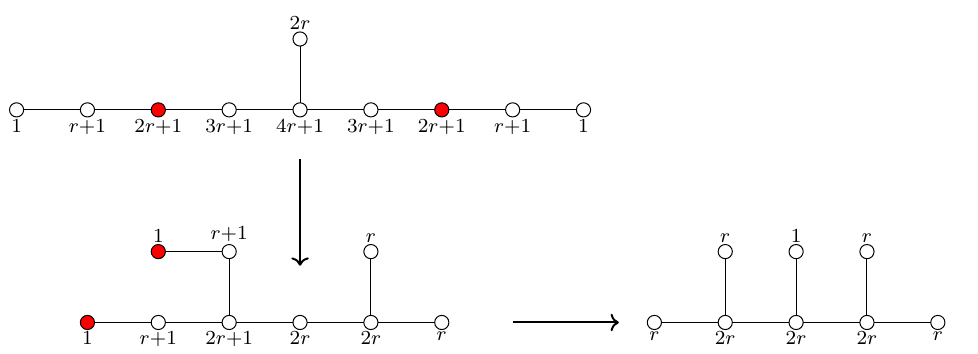
Figure 4. The FI deformations leading from the magnetic quiver of the 5d SCFT (the second quiver in figure 3) to the 3d mirror of the USp(2 r ) 2 gauge theory (3.23).